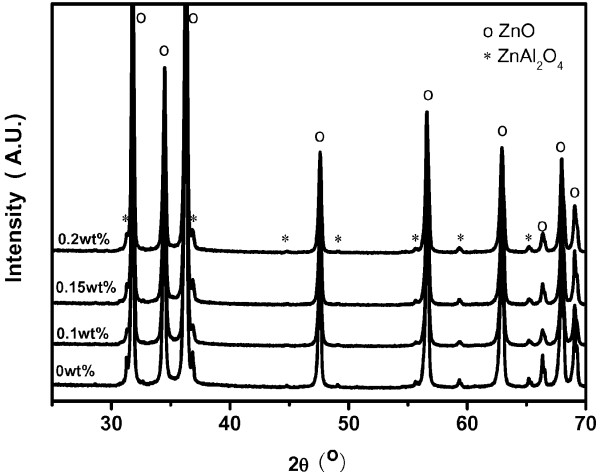
 X-ray diffraction patterns of sintered ceramics. X-ray diffraction patterns of the 0, 0.1, 0.15, and 0.2 wt.% Y2O3-doped AZO ceramics sintered at 1,300°C.